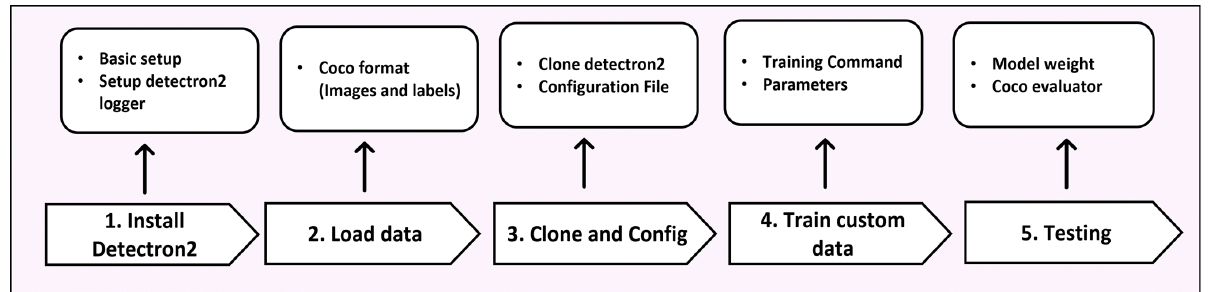
Figure 8. Main steps in the development of Faster R-CNN model.